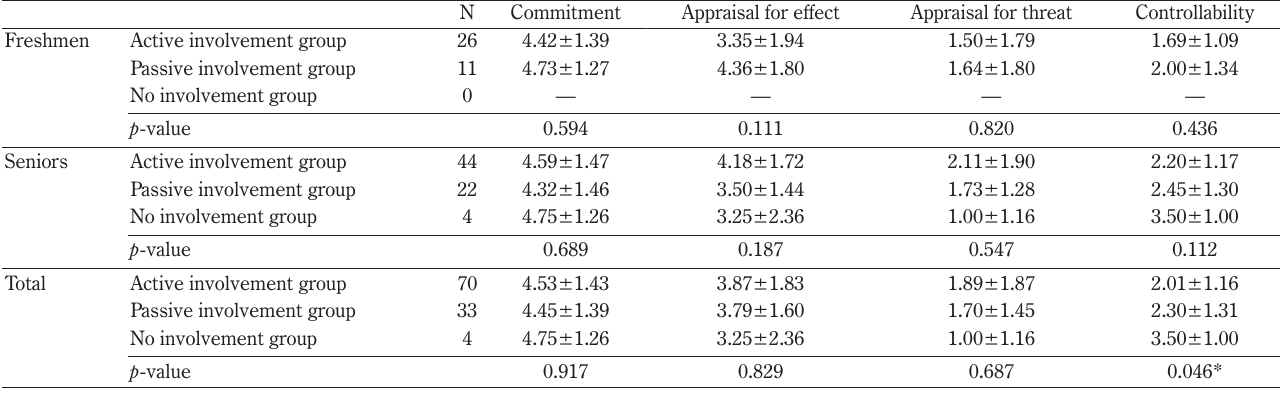
Table 5 Mean/standard deviation and significant difference of CARS for the